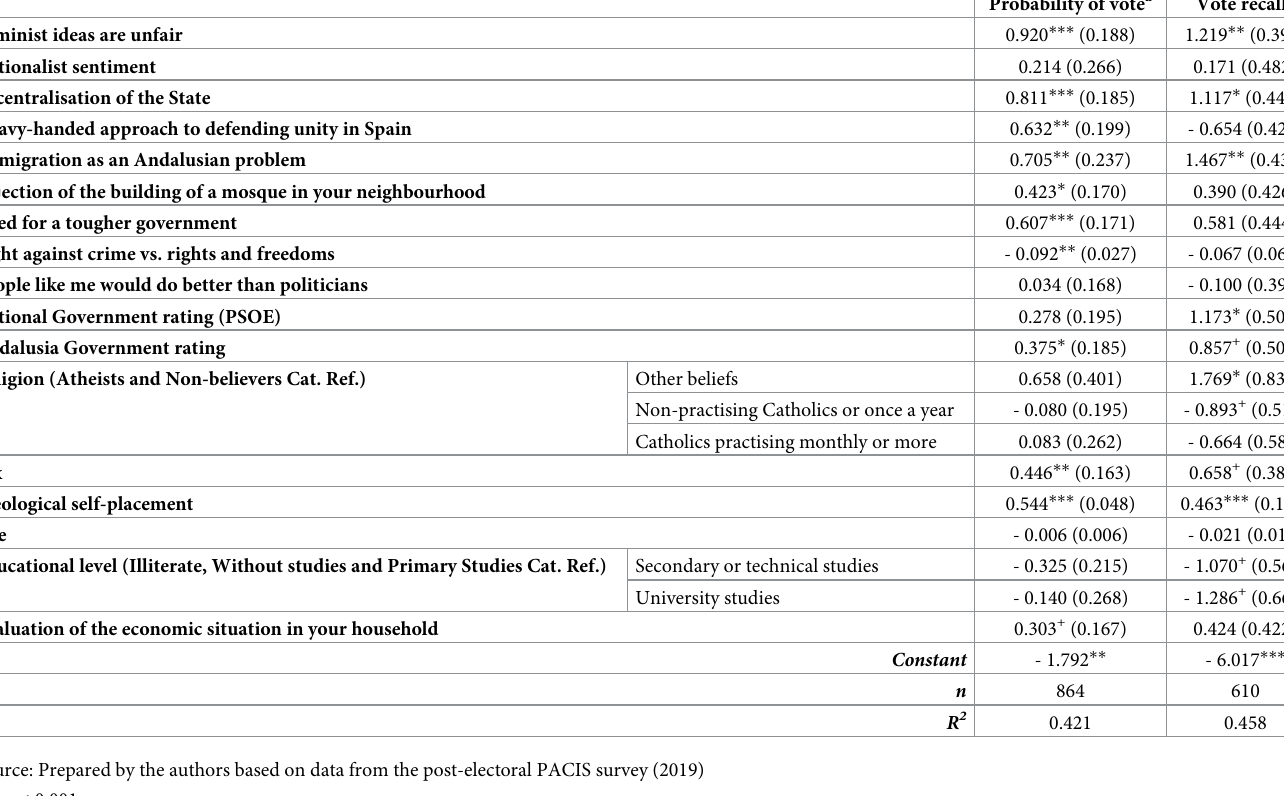
Table 3. Results of the regression models of support for